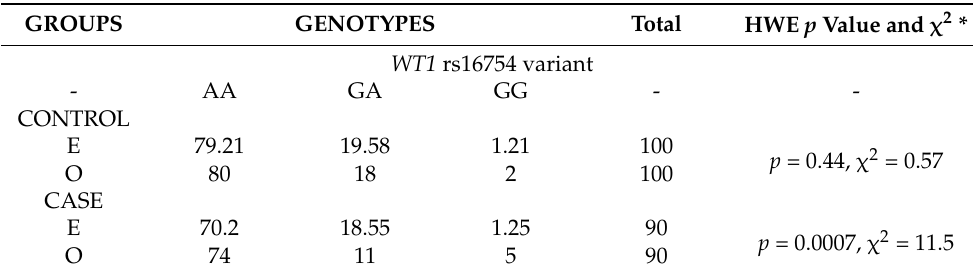
Table 2. Hardy–Weinberg equilibrium (HWE) for WT1 rs16754 variant in case and control groups according to expected (E) and observed (O) values.